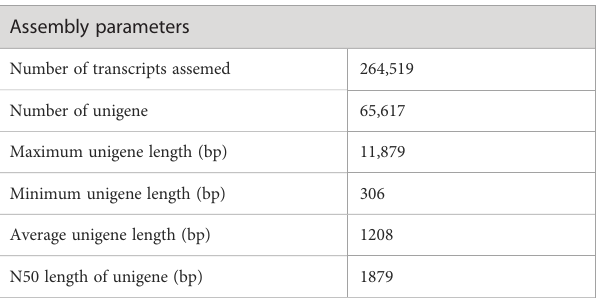
FIGURE 2 Phylogenetic relationships between P. huashanica and other genomes.